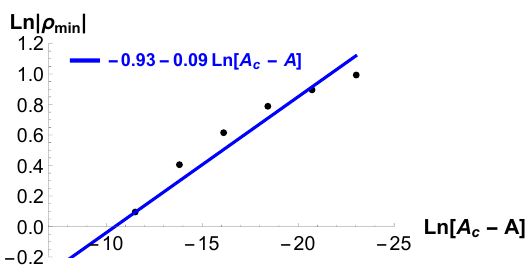
Figure 7 . Depicted is the logarithm of − ρ min as a function of the logarithm of the deviation from the critical amplitude. The slope of a linear fit is found to be − 0 . 09 ± 0 . 025 . Open